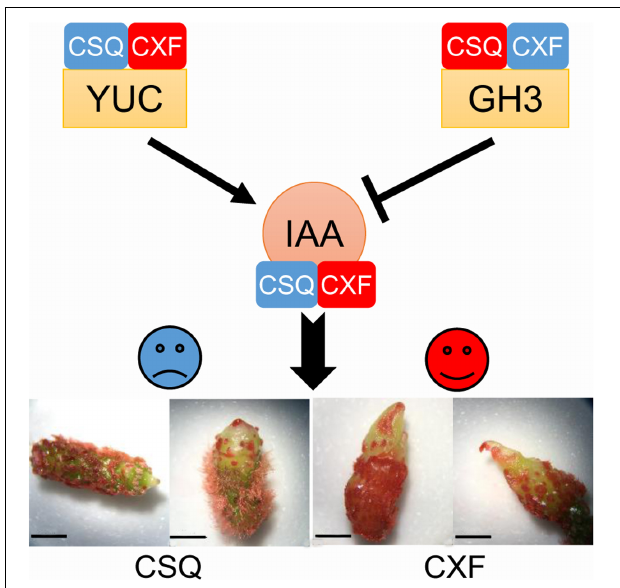
FIGURE 7 | The role of YUC-mediated auxin biogenesis in shoot regeneration from rhizome in Cymbidium . Blue and red indicate downregulation and upregulation, respectively. YUC, YUCCA, indole-3-pyruvate monooxygenase; GH3, auxin-responsive Gretchen Hagen3 gene family; IAA, endogenous indole-3-acetic acid. Bar = 10